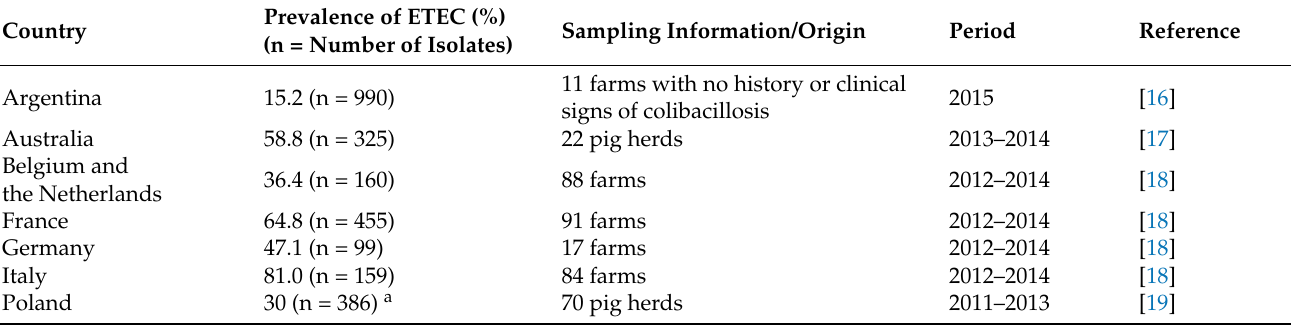
Table 2. Prevalence of ETEC in several countries from studies published since